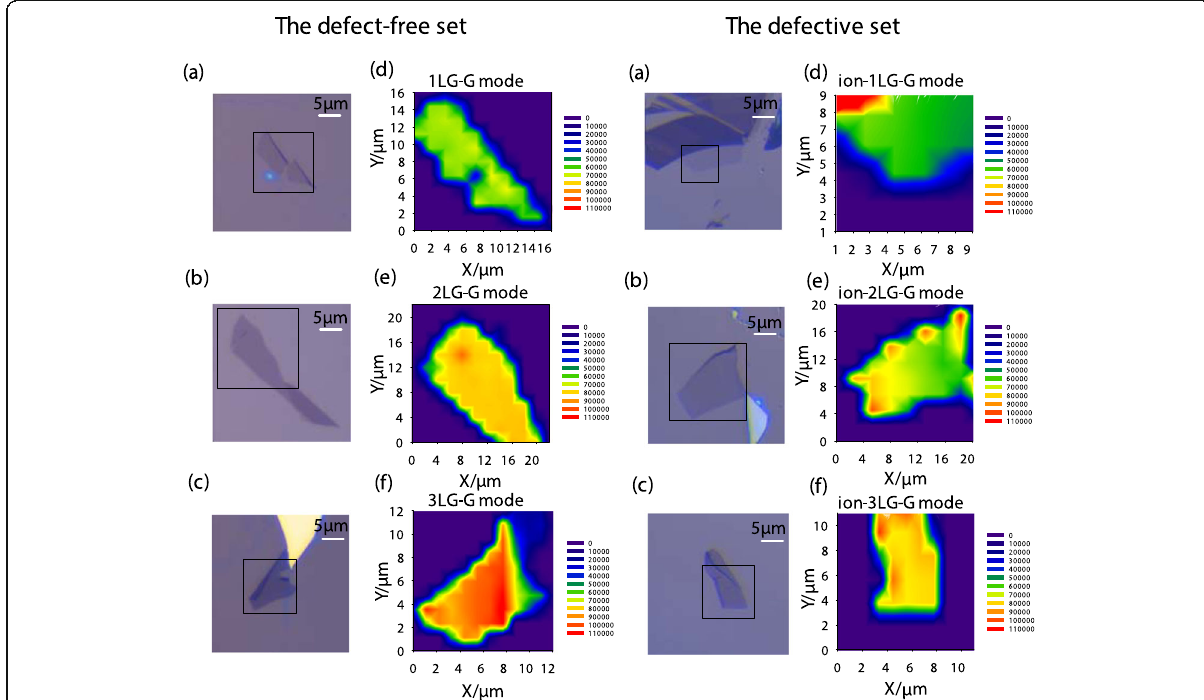
Fig. 2 The mappings of I (G) for defect-free and defective 1LG, 2LG, and 3LG and the optical microscopic images of corresponding